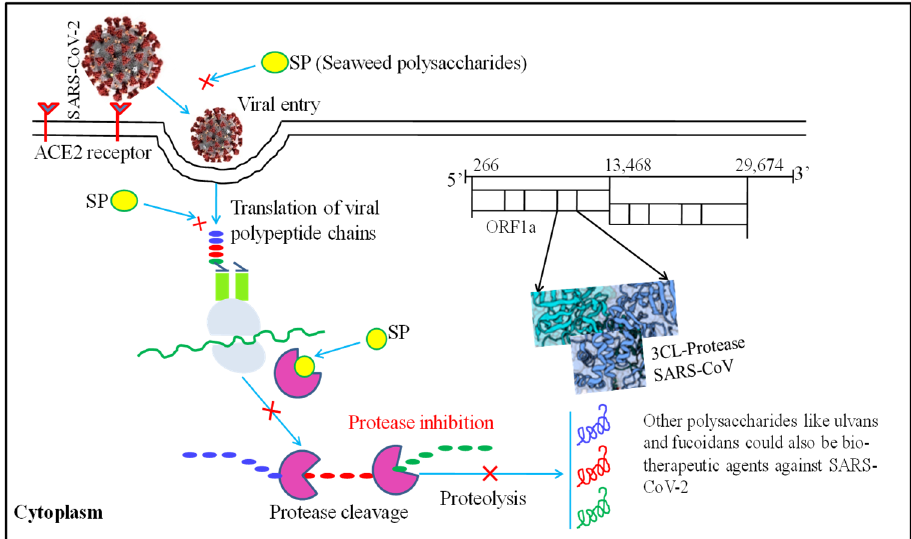
Figure 2. Molecular mechanism of seaweed polysaccharides (SPs) used as a potential biotherapeutic agent against SARS-CoV-2. The figure was modified from